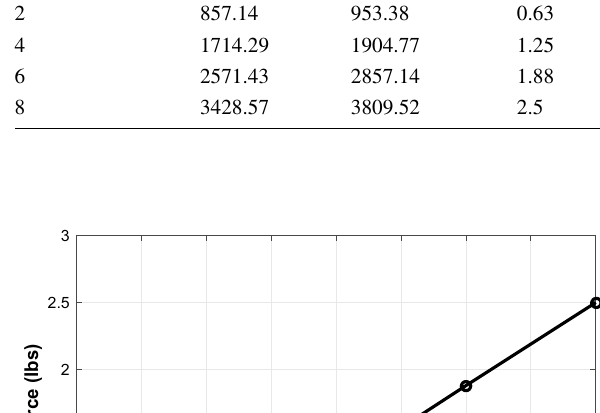
Table 3 Buoyancy force of polypropylene beads acting on cuttings Polypropylene con- Mass of beads centration (ppb) Injected (g)